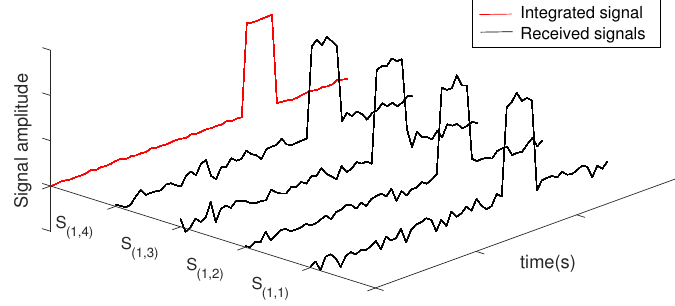
Figure 7. Radar pulse